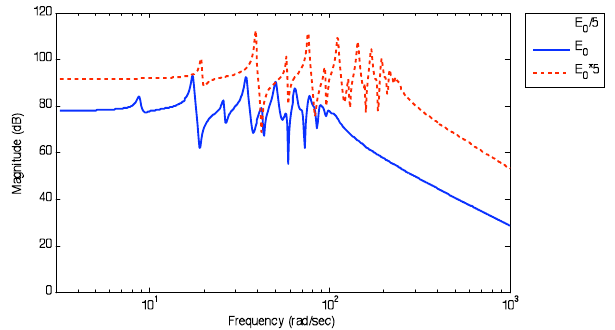
Fig. 4. Bode diagram of for different Young modulus